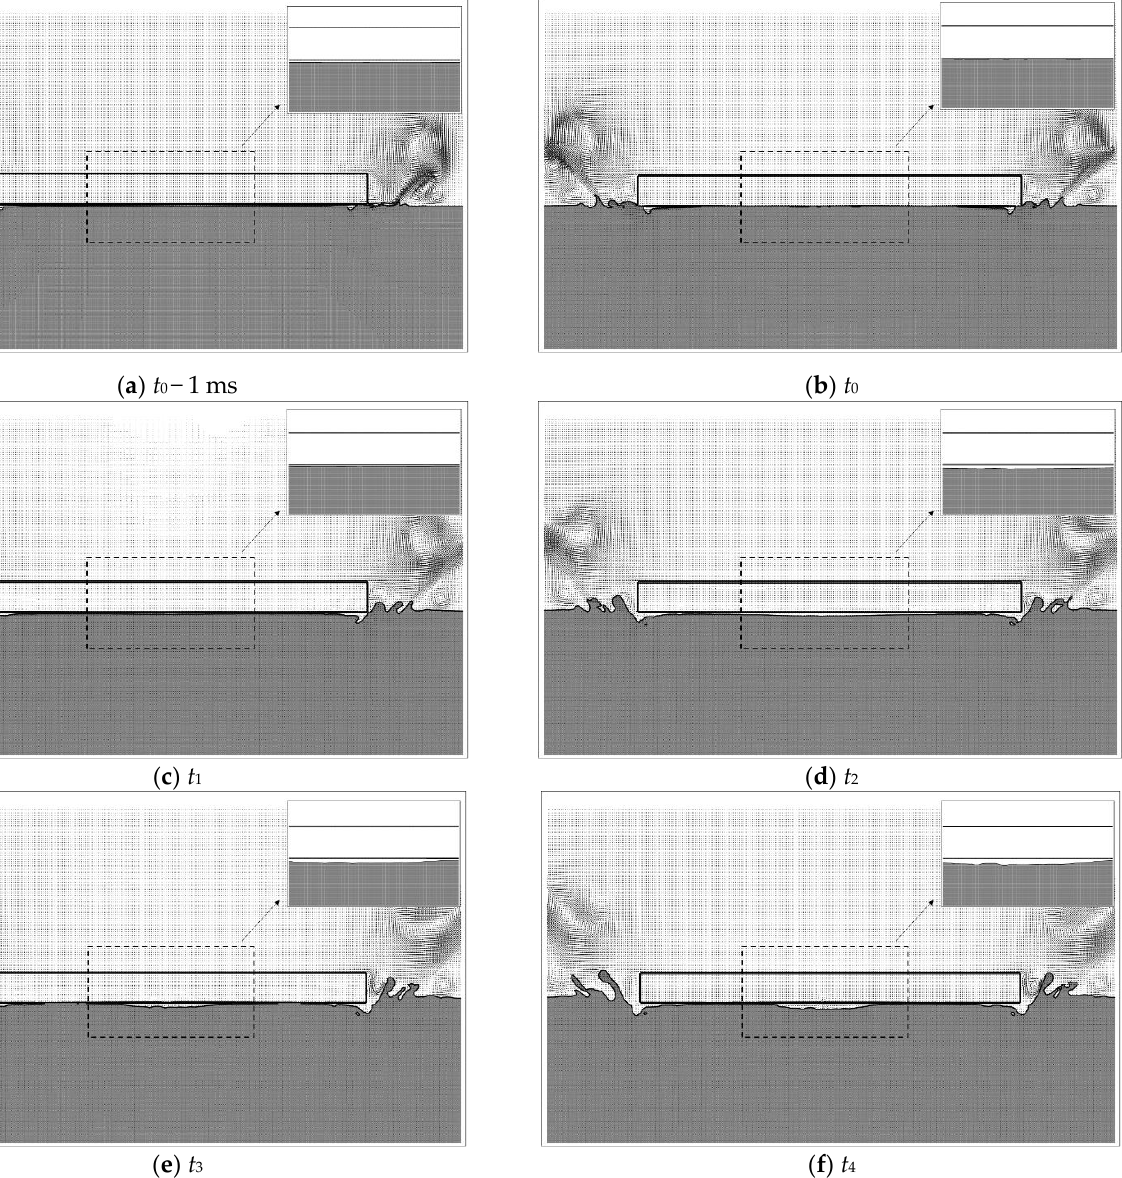
Figure 9. The free surface and corresponding flow field from t 0 to t 4.